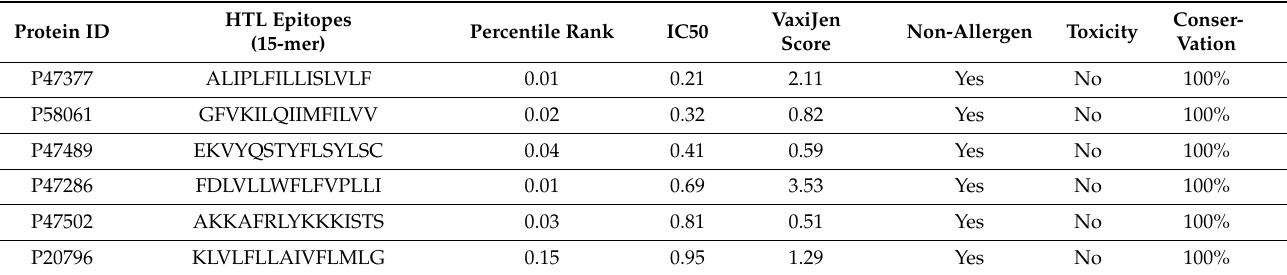
Table 3. Conserved and most immunogenic HTL